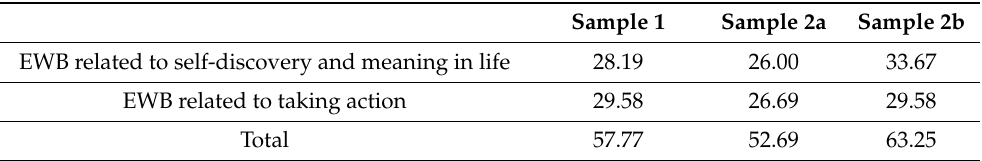
Table 2. Differentiating between items of the QEWB rather related to self-discovery and meaning in life vs items rather related to taking action.